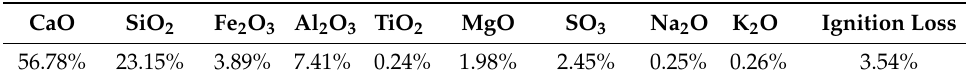
Table 4. Chemical and mineral composition of the